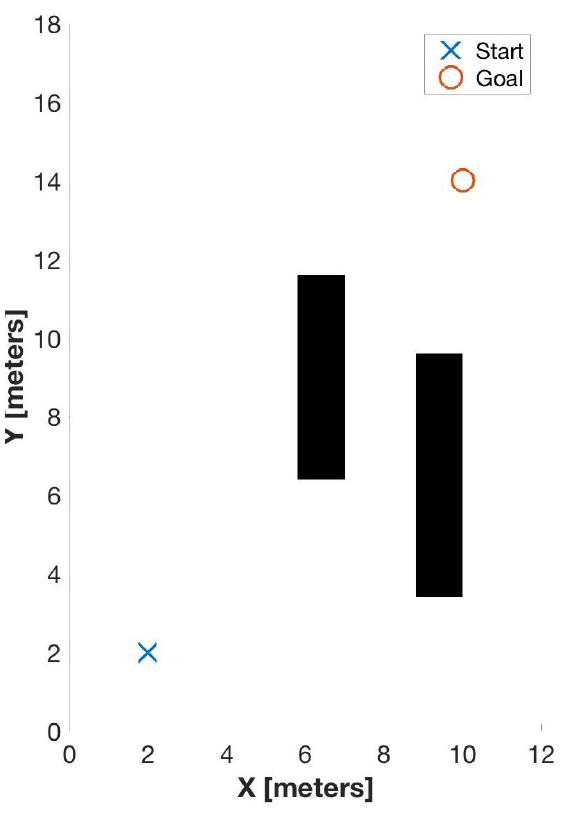
Figure 9. Testbed for Case Study II (obstacles represented by black